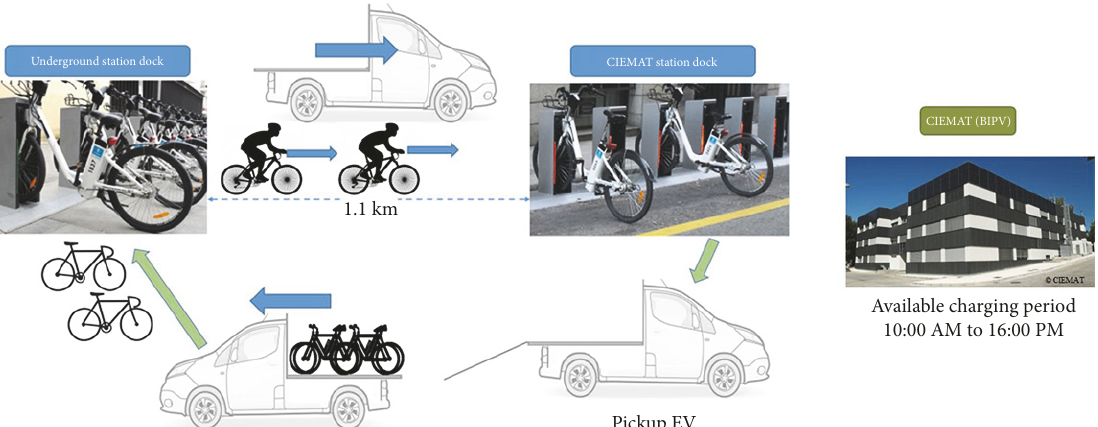
Figure 9: e-bike sharing system mobility description.